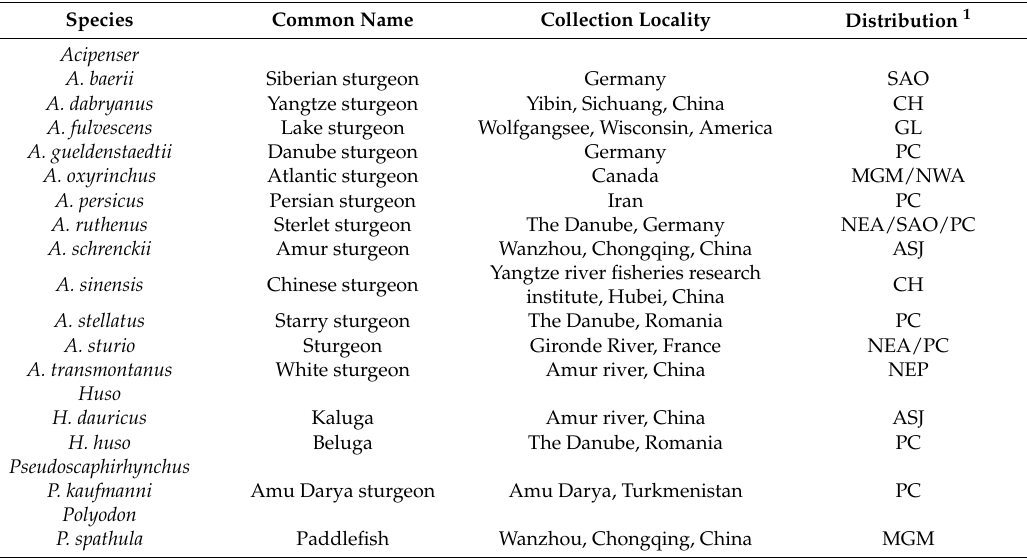
Table 1. Sample collection list of all species used in this